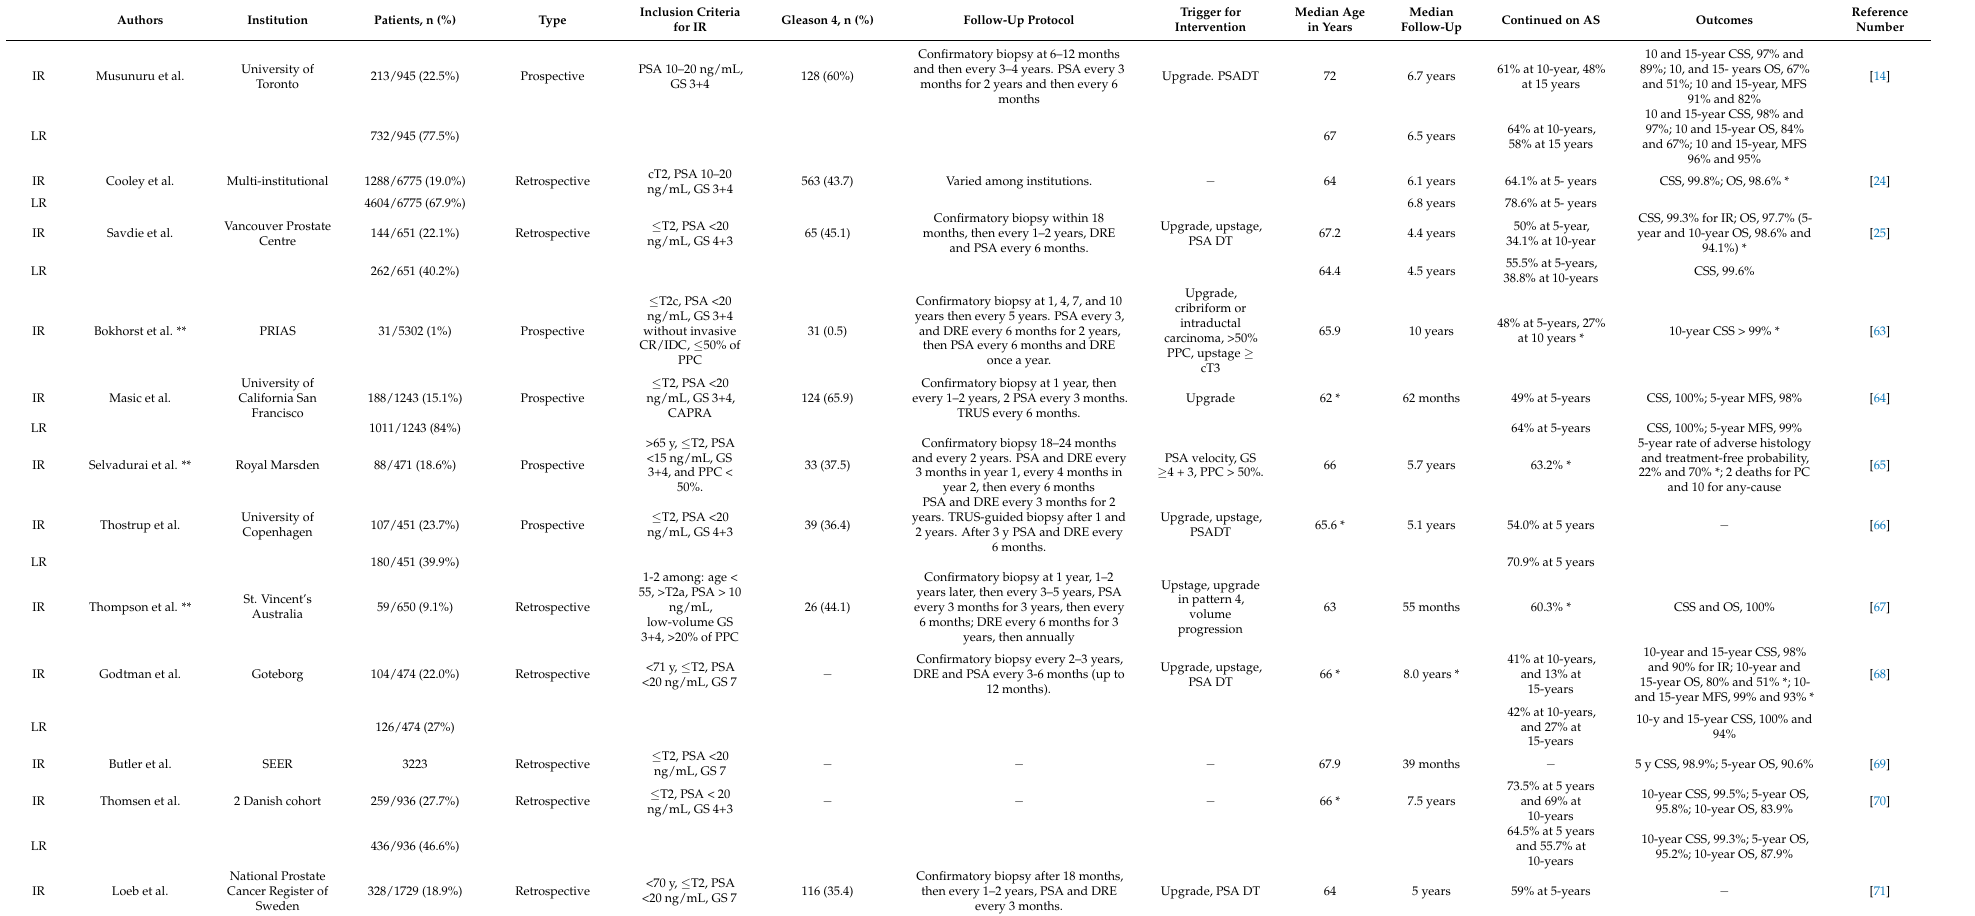
Table 2. Comparison of Active Surveillance outcomes between intermediate-risk and low-risk